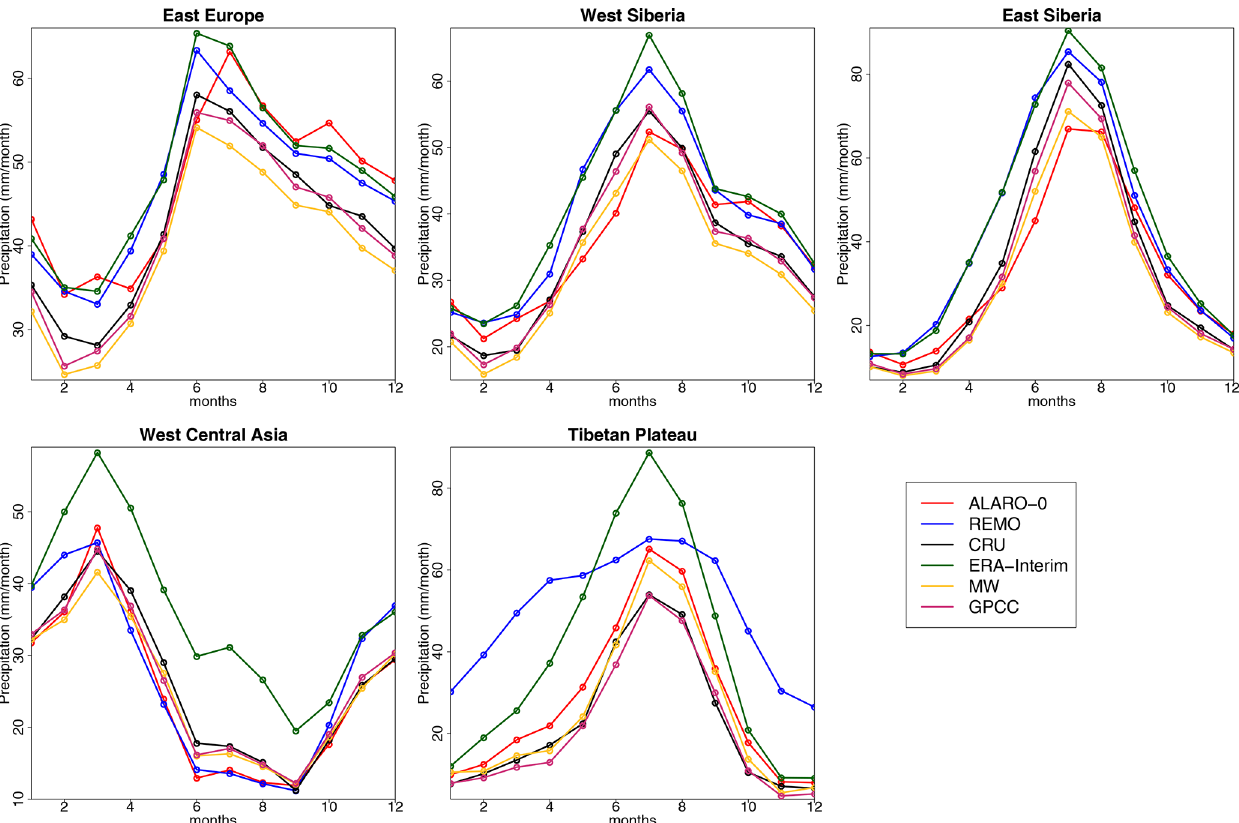
Figure 12. Annual cycles of precipitation (mm per month) for both RCMs (ALARO-0 and REMO) compared to the ERA-Interim reanalysis, MW, GPCC, and CRU observational data over five